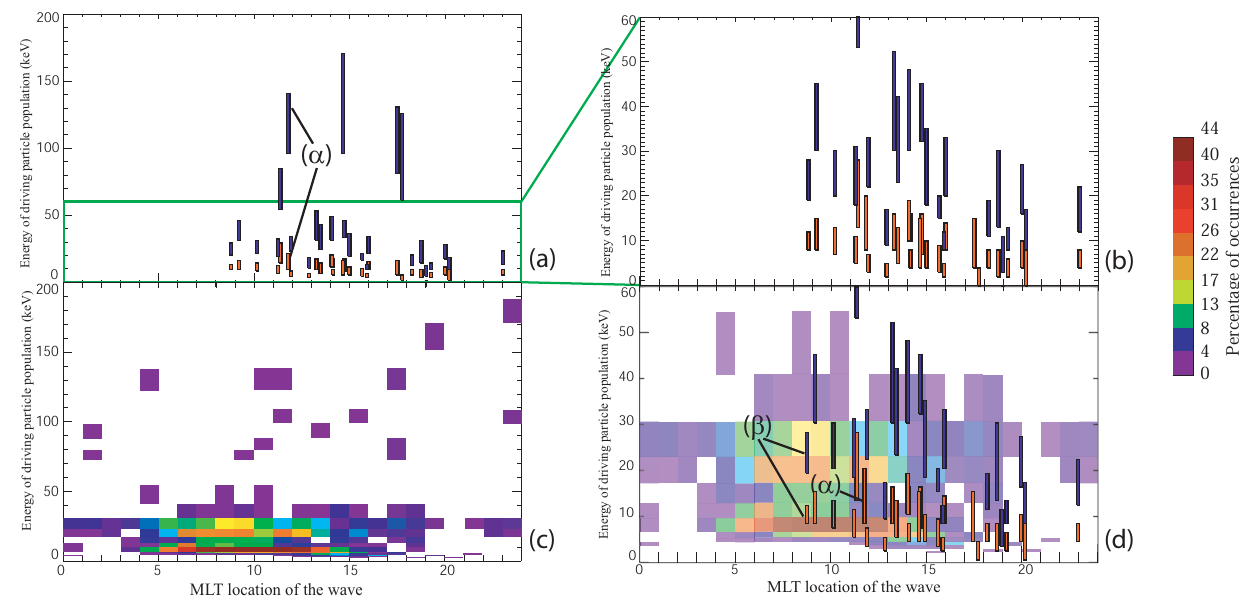
Fig. 6. Inferred particle energy requirements to drive the 27 wave events under study presented with the probability of that particle population existing in the magnetosphere, from the statistical study of Baddeley et al. (2004). Panel ( a ) indicates the energy of the particles which could provide free energy for each of the pulsation events observed by DOPE as a function of MLT. The possible particle energy for a drift or drift-bounce resonance interaction are indicated in blue and red respectively. Panel (a) indicates all particle energies up to 200keV. Panel ( b ) is a larger-scale plot of the area indicated by the green box in (a), encompassing particles of up to 60keV. panels ( c ) and ( d ) indicate the statistical probability of a particle population of a specific energy existing in the magnetosphere. The figures are colour coded as a function of percentage of the number of IDFs in each MLT bin with the scale indicated on the right hand side of the plots. Panel (d) indicates the particle requirements to drive the wave through a resonant interaction for particles of < 60keV. In this panel the inferred particle energy requirements for wave growth from panel (b) are overplotted for an easier comparison. The specific events (marked α and β) are discussed in the